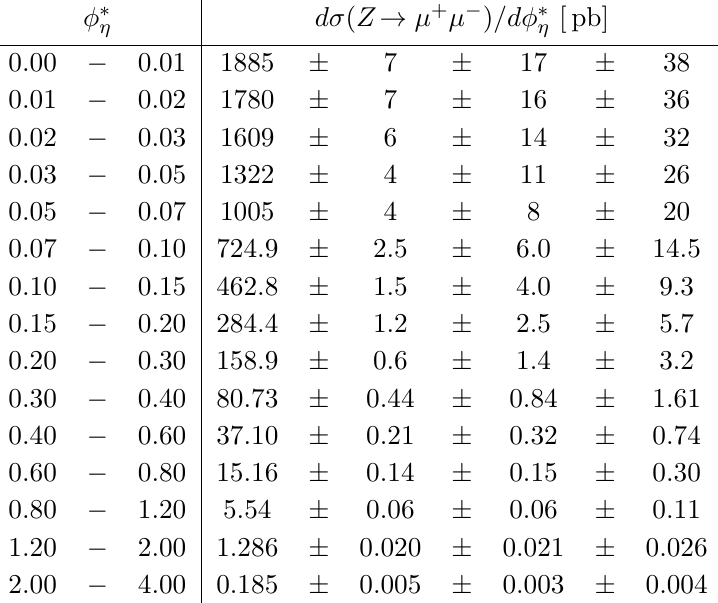
Table 16 . Measured single differential cross-sections in interval regions of φ ∗ is statistical, the second systematic, and the third is due to the